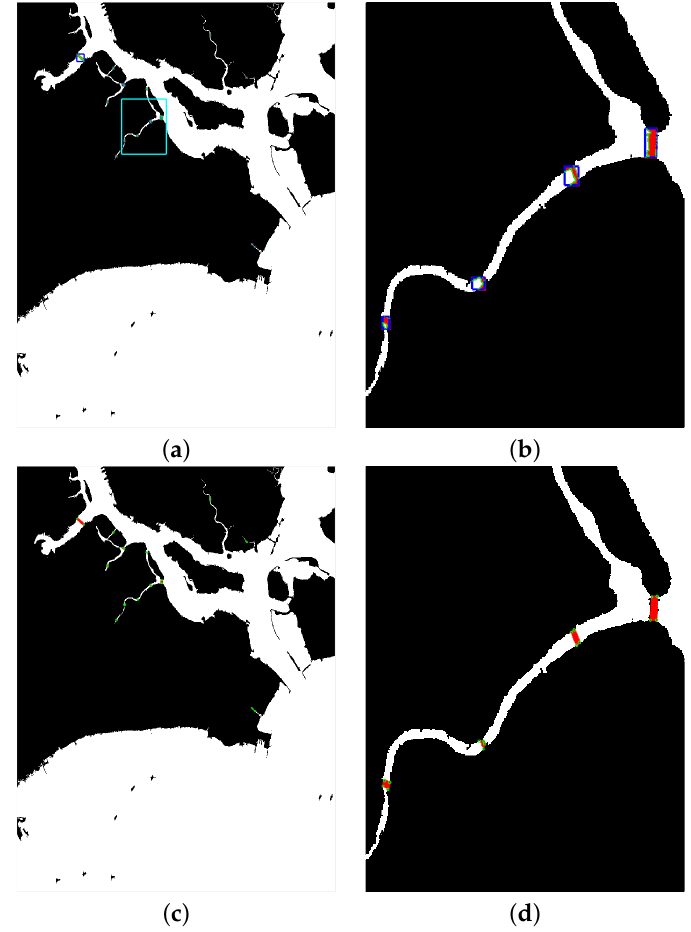
Figure 16. Result of bridge body recognition, where the recognized bridge bodies marked in red are mapped on the water network result: ( a ) the result of the spatial method, where the recognized bridge bodies are marked in a blue box and the extracted contour pixels by spatial relationship are marked in green; ( b ) the local region marked in cyan in ( a ); ( c ) the result of the proposed method, where the extracted feature points are marked in greed circles; ( d ) the result of the local region of ( c